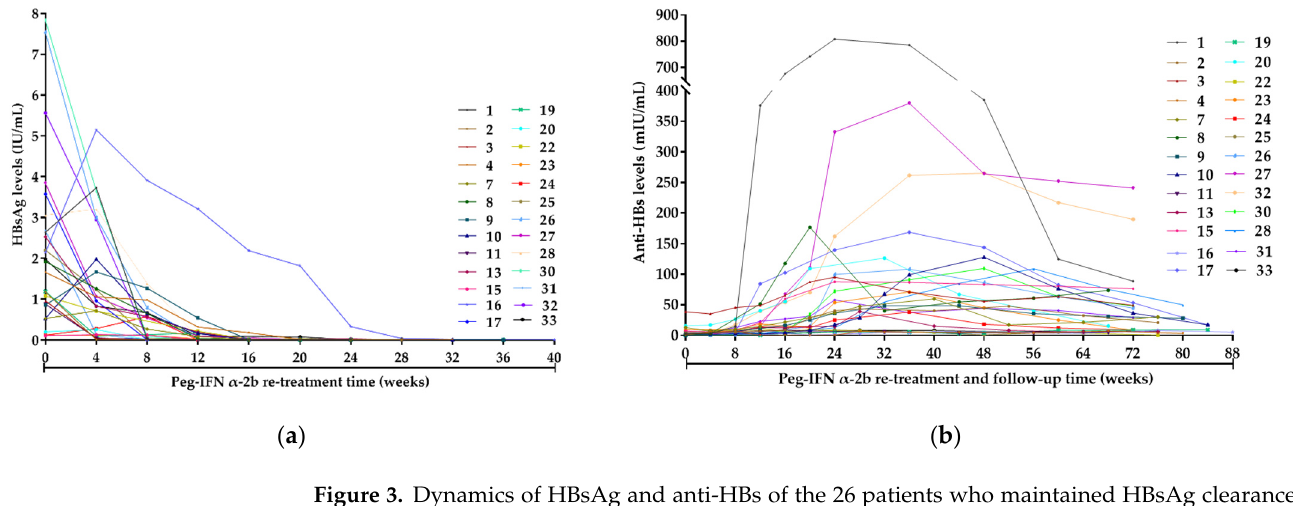
Figure 3. Dynamics of HBsAg and anti-HBs of the 26 patients who maintained HBsAg clearance during follow-up. ( a ) Dynamics of HBsAg of the 26 patients during peg-IFN α -2b re-treatment (These 26 patients remained HBsAg-negative during the follow-up period and are not shown in the figure); ( b ) Dynamics of anti-HBs of the 26 patients during peg-IFN α -2b re-treatment and follow- up. Week 0 was defined as the time when the patients were enrolled in this study. Abbreviations: HBsAg, hepatitis B surface antigen; anti-HBs, hepatitis B surface antibody; Peg-IFN- α , peginterferon alpha.